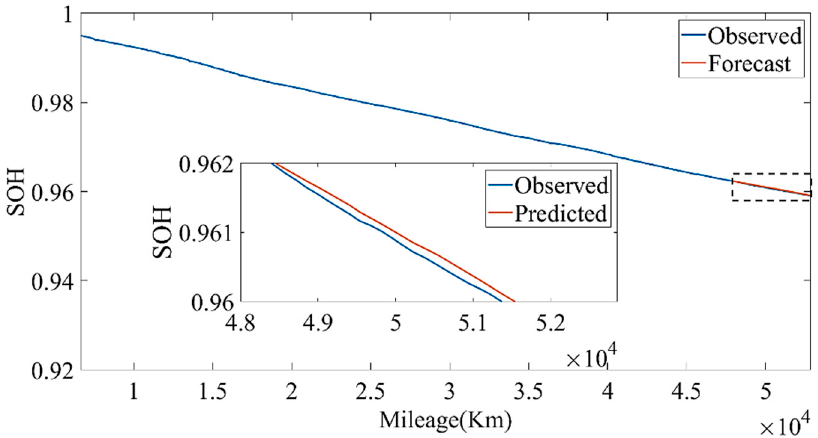
Figure 27. The SOH estimation result based on LSTM.